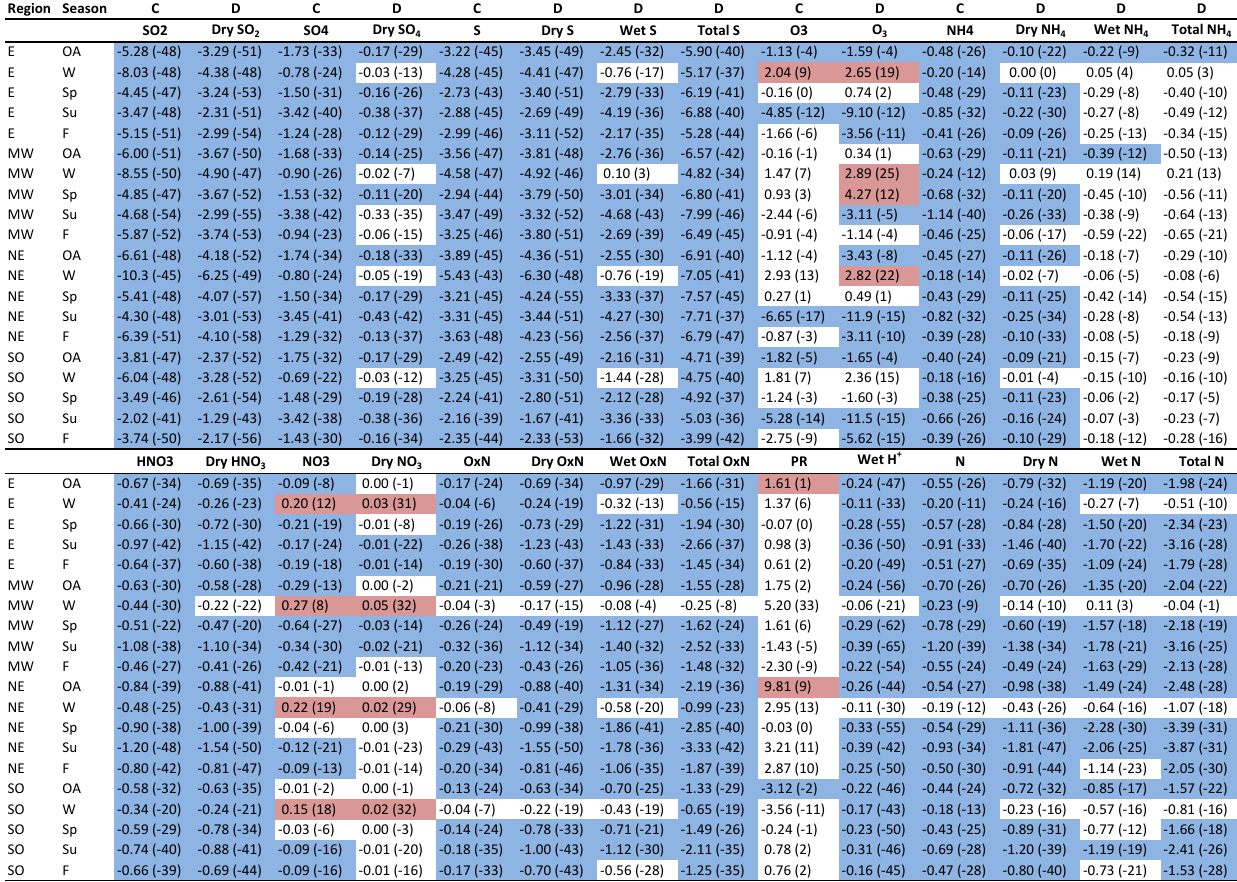
Figure 4. P1-to-P4 changes expressed in Table 2 units and as relative differences (%); see Notation Section for definitions. Region Season